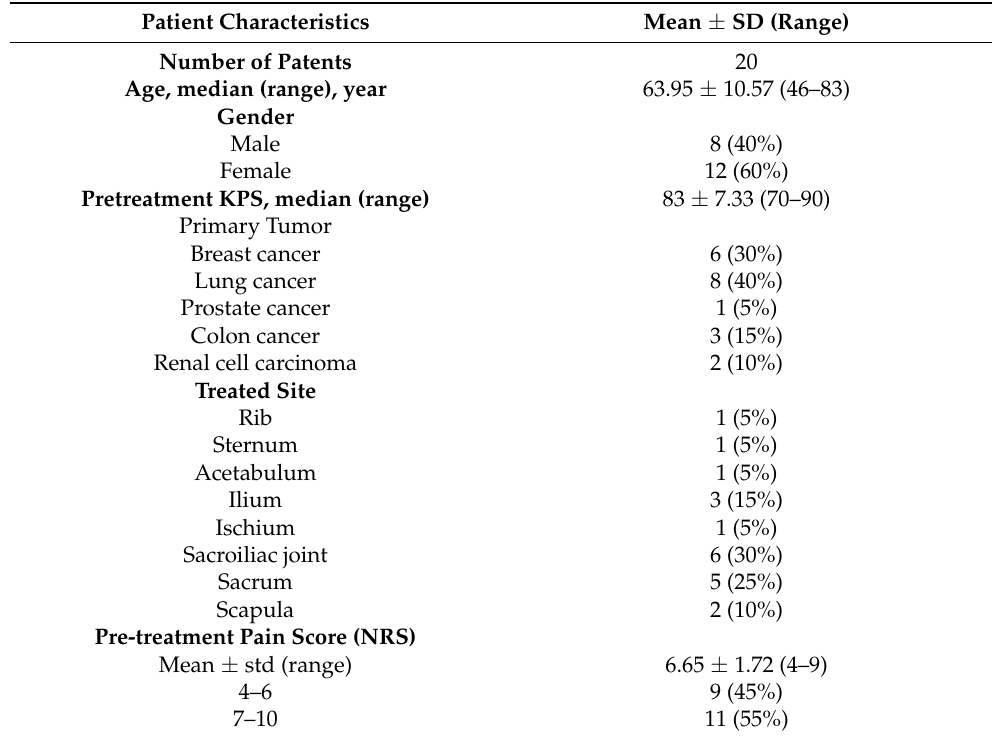
Table 1. Patient status and demographics of overall